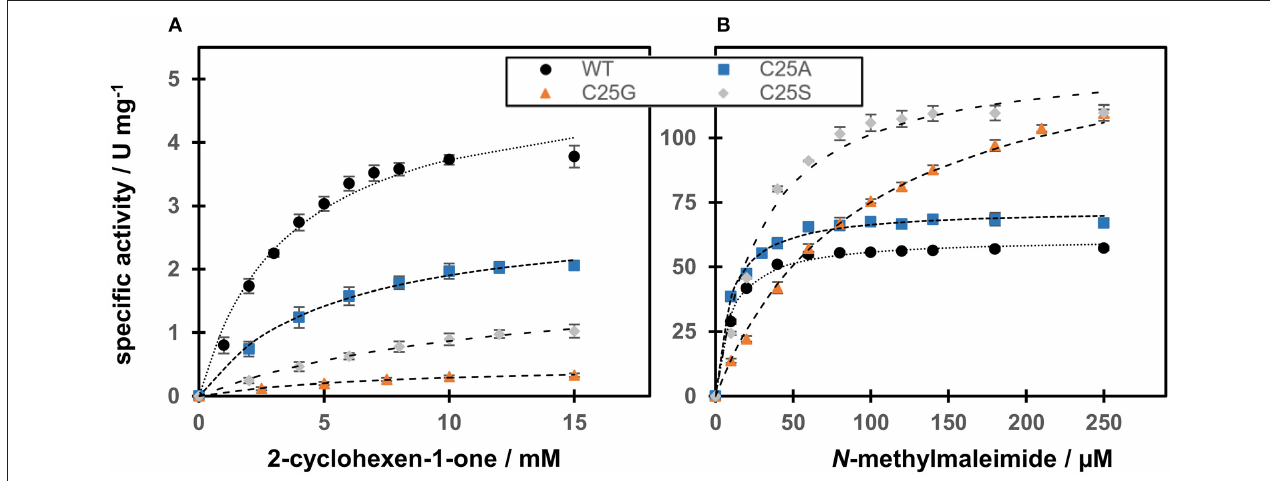
FIGURE 5 | Steady-state kinetics of OYERo2a WT and Cys variants regarding substrate dependence. The assay contained excess NADPH and different amounts of the substrates (A) 2-cyclohexen-1-one or (B) N -methylmaleimide. The Michaelis-Menten model has been used to fit the data.